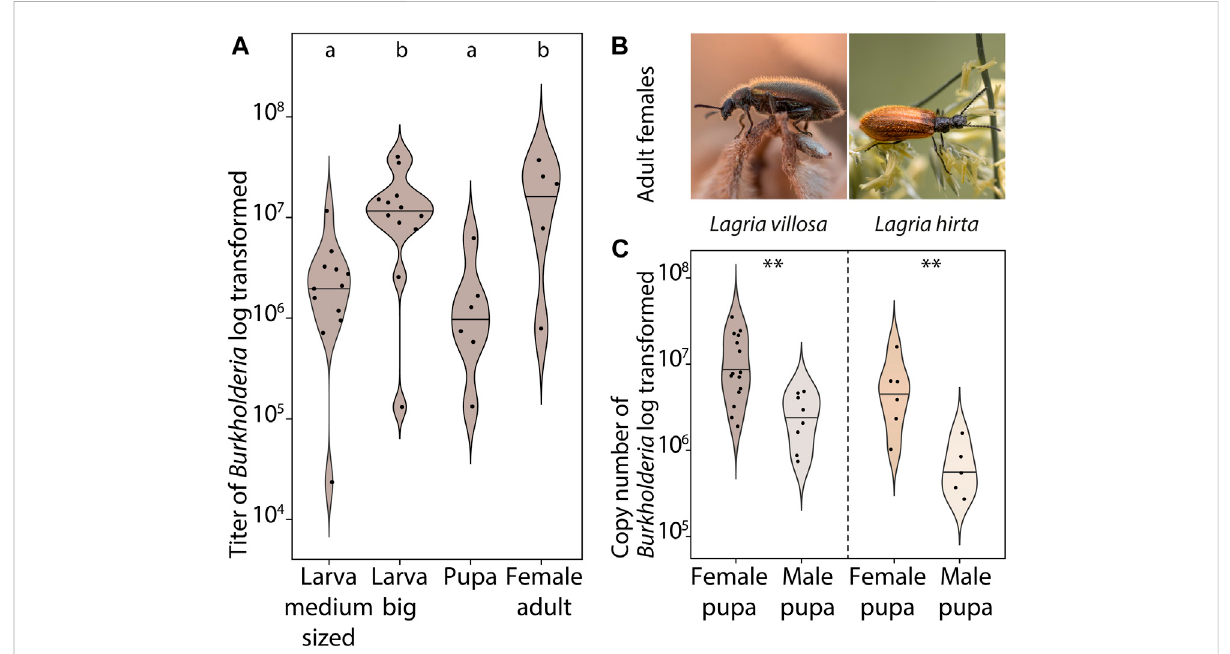
FIGURE 1 Symbiontabundanceinmaleandfemale Lagria pupae. (A) Abundanceof B.gladioli (gyraseBgenecopies)of fi eld-collected L.villosa larvae(sex is not known for medium sized and big larvae), pupae (sex unknown), and adult females. Different letters indicate signi fi cant differences between experimental treatments (Kruskal – Wallis test, χ 2 = 14.3, df = 3, p -value = 0.0026, posthoc Dunn ’ s Test) (B) Photographs of Lagria females from the two evaluated species L. villosa (left, Brazil) and L. hirta (right, Germany). (C) Abundance of B. gladioli copies (16S rRNA gene of B. gladioli ) of fi eld-collectedmale andfemalepupaeof L.villosa (left)and L.hirta (right). Asterisks indicatesigni fi cantdifferencesbetweenfemalesand males(Two Sample t -test, ** p <